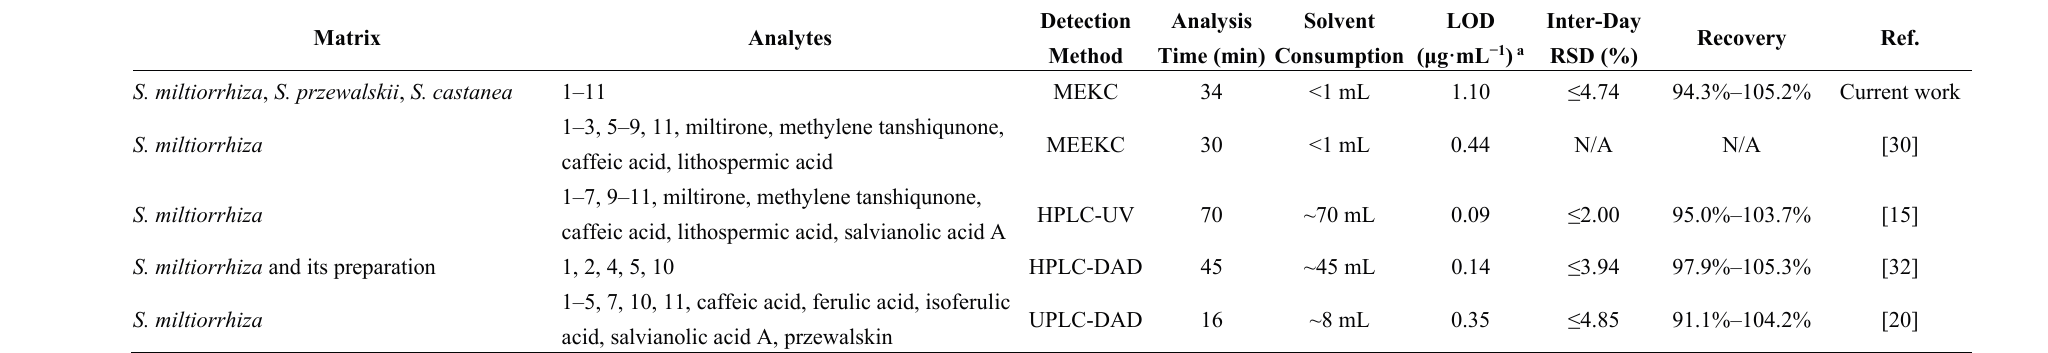
Table 4. Comparison of current work and some other